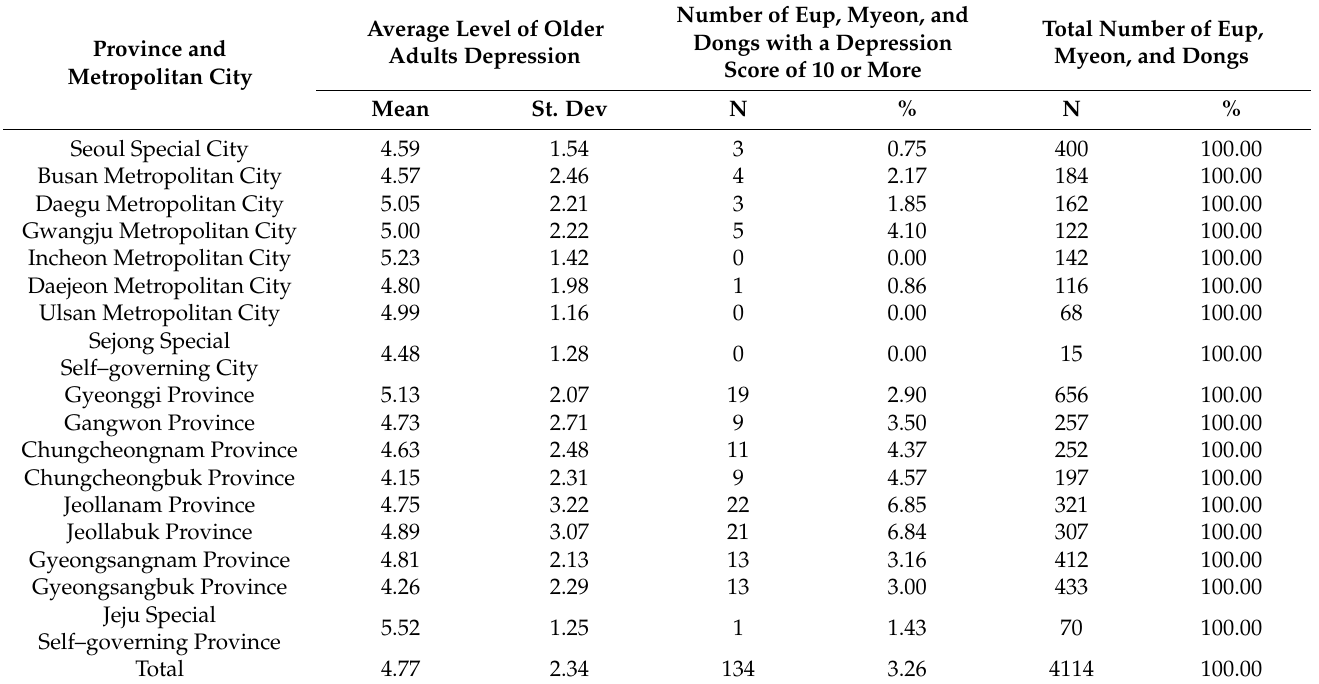
Figure 2. Level of older adult depression in Eup, Myeon, and Dongs. Table 5. Average level of older adult depression in Eup, Myeon, and Dongs by Province and Metropolitan City.